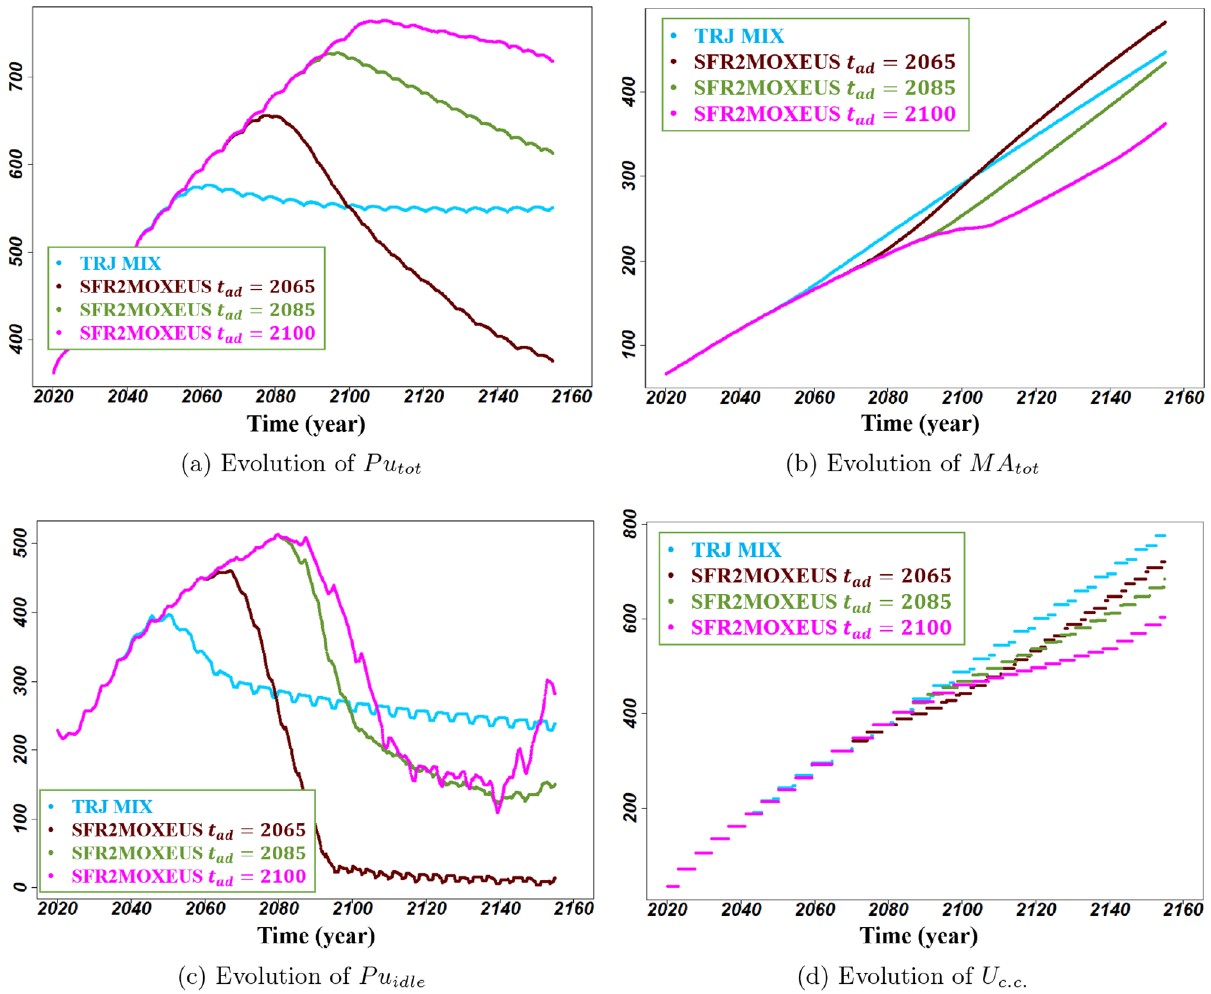
Fig. 9. Evolution of Pu tot , MA tot , Pu idle (in t) and U c.c. (in kt) from optimal adaptive strategies for three t ad in SCN SFR2MOXEUS , compared with that in TRJ MIX